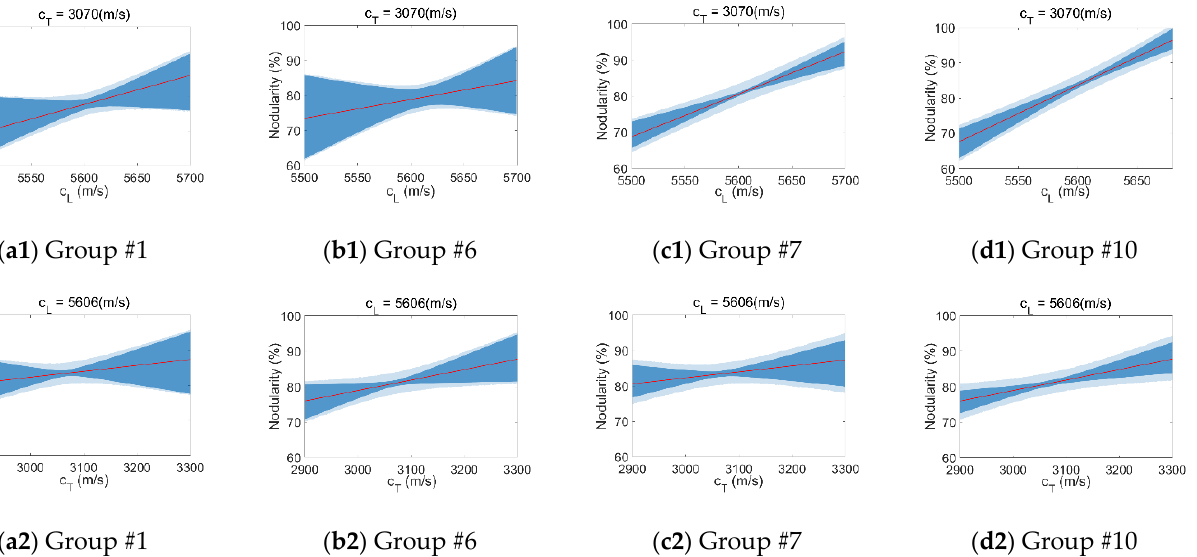
Figure 8. (Color Online) The regression function and its associated 90% confidence bounds of hierarchical Bayesian regression model from the first week only. ( a1 – d1 ) Cross-sections at c T = 3070 m/s for Groups #1, #6, #7, and #10, and ( a2 – d2 ) cross-sections at c L = 5606 m/s for Groups #1, #6, #7, and #10.